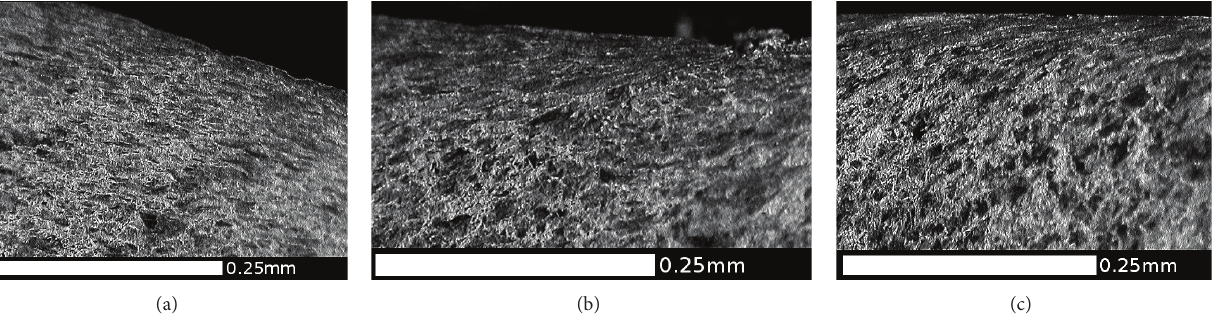
Figure 13: OM images of microstructure in the flange root area: (a) Region C1, (b) Region C2, and (c) Region C3. These show the microstructure sheared to the right (toward the centre of the tread) which is consistent with the direction of tangential forces on this part of the wheel (Figure 4). The depth of shearing is about 0.1 mm. A crack is visible in Region C2, at the same angle as the sheared microstructure, about 0.2 mm long. Cracks are also visible on the surface here (see Figure 3).